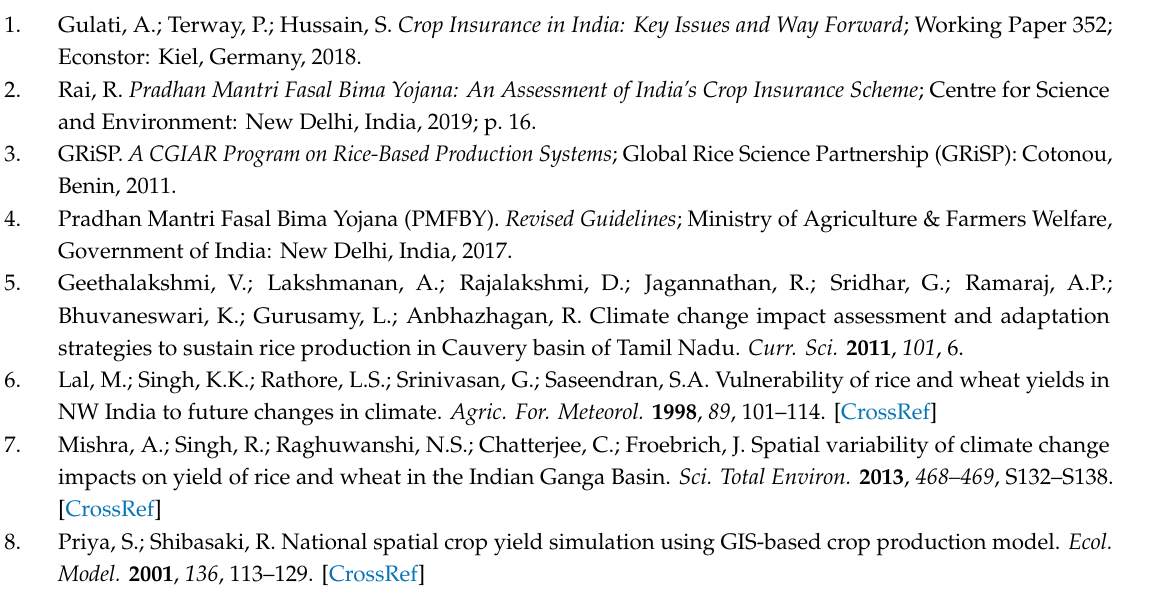
rice in India; Figure S4: District-specific d values and histogram of the number of observations and the range of d. The histogram chart has d values as the X-axis and the number of districts as the Y-axis; Figure S5: Time series of observed and simulated yield anomalies and rainfall anomalies. Curves are observed yield anomalies (Observed, green), simulated yield anomalies (Simulated, magenta), and rainfall anomalies (Rainfall, blue). The left Y-axis represents the observed and simulated yield anomalies; the right Y-axis represents the rainfall anomaly. Years are on the X-axis. The red dotted lines show the error between observed and simulated yield anomalies; Figure S6: The grouped boxplots of observed and simulated yield anomalies for the years 2016 and 2017. The blue boxplots represent the observed yield anomalies; the red boxplots represent the simulated yield anomalies; The number of observations was given above the boxplot; the line in the boxplots are median; squared black dots are mean and red diamond dots are the outliers. Plot a consists of states from Southern India, plot b consists of states from Central India and Northern India, and plot c consists of states from Northern India and the Himalayan regions; Figure S7: The high-resolution spatial distribution map of actual yield for Kharif 2016 (left-hand side) and Kharif 2017 (right-hand side); Figure S8: The high-resolution spatial distribution map of yield loss for Kharif 2016 (left-hand side) and Kharif 2017 (right-hand side); Table S1: The states and their acronyms of the study area. The symbol * represents the selected states for this study, according to data availability (see below); Table S2: The varieties and calibrated genetic coe ffi cients were used in this study; Table S3: The parameters used for analyzing the assessment of goodness index; Table S4: The state-wise information on inputs such as varieties used, sowing date, and irrigation status over the pixels within the state after the calibration; Table S5: State-wise average of RMSE and d which explains the goodness index of simulated yield loss with observed yield loss; Table S6: The state-wise observed and simulated yield information for the Kharif 2016 and 2017. The green shadowed data shows a < 500 kg error. The unit of the data is kg /